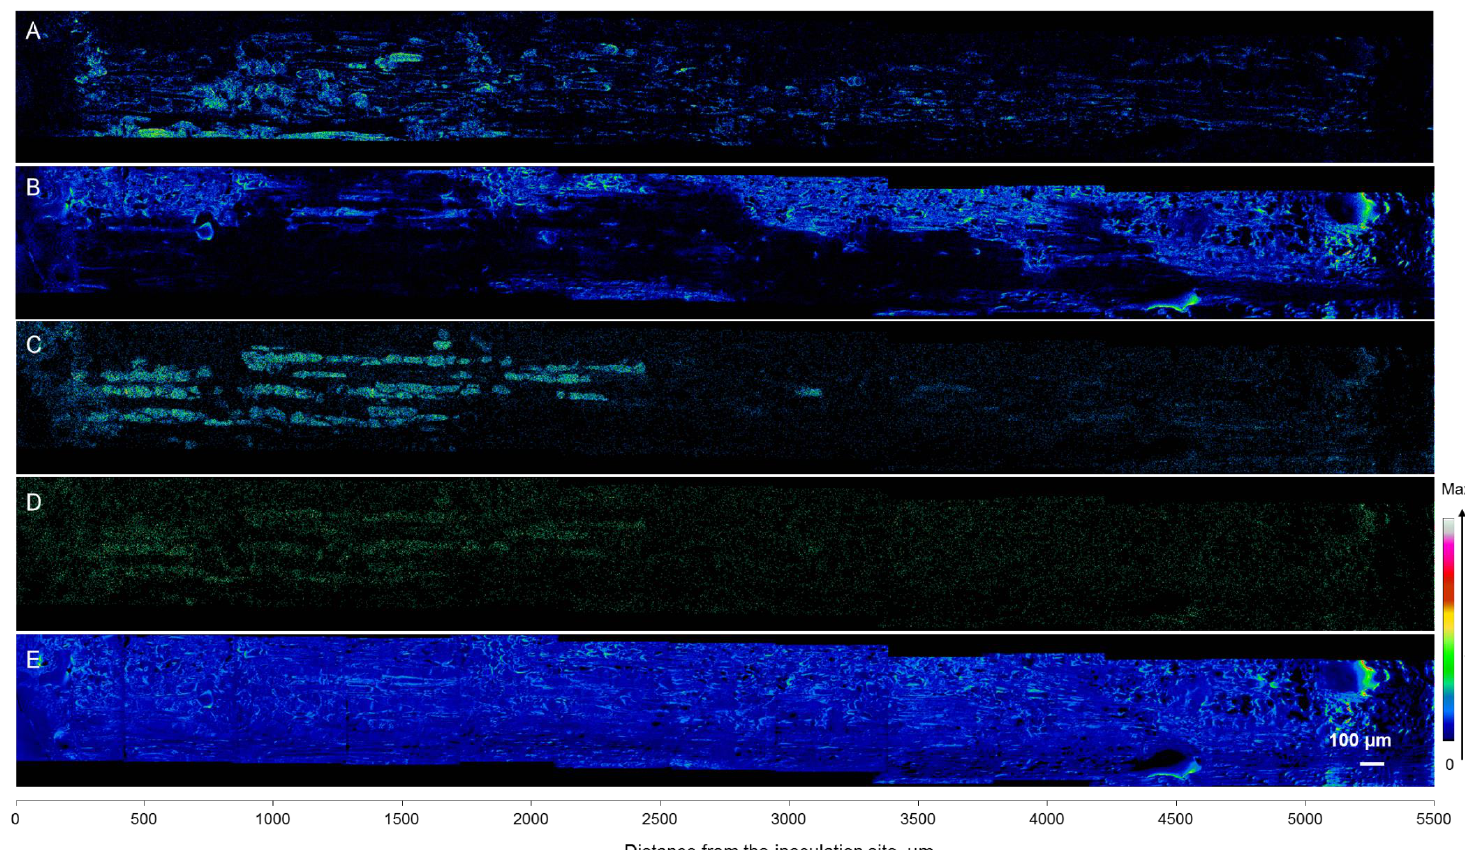
Figure 8. Positive ToF-SIMS images of Norway spruce phloem from the inoculation site (on the left) upwards along the sapling stem (to the right). The outer bark is at the upper side of each image. Images of m / z at 184 ( A ), 302 (B), 245 ( C ), and 291 ( D ) represent living cells, abietic acid, stilbene glucoside astringin, and ( + )-catechin, respectively. Total ion images ( E ) represent the structures of the sample surface. The colors of the pixels correspond to the ion intensities of the compounds on the specimen’s surface. Specifically, abietic acid, ( + )-catechin, and stilbenes were absent from dark areas, showed mid-range concentrations in blue and green areas, and had the highest concentrations in yellow and red areas.